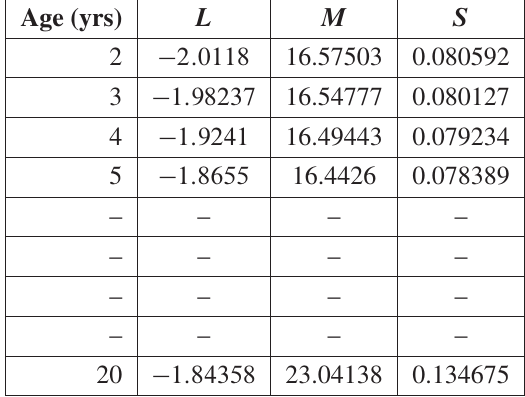
Table 1. L , M , S parameters for male.